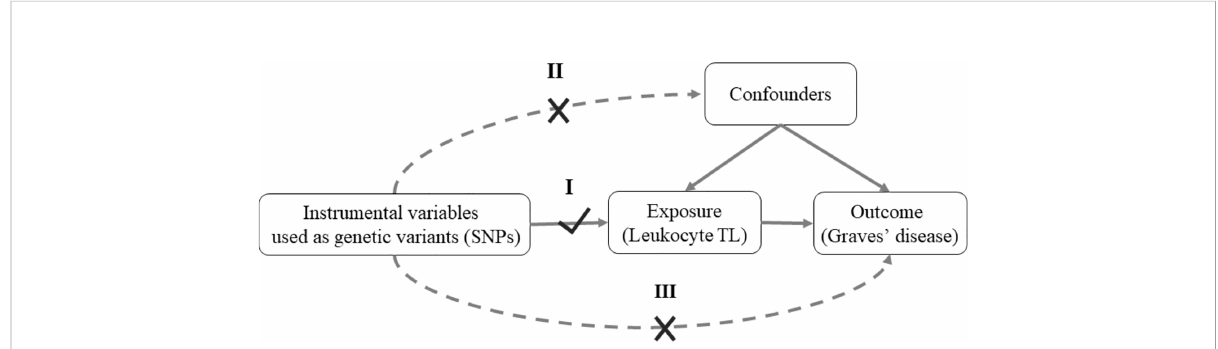
FIGURE 1 Mendelian randomization model of leukocyte TL and risk of Graves ’ disease. MR depends on three assumptions: I. Relevance: The genetic variants are associated with the exposure of interest (Leukocyte TL); II. Independence: The genetic variants are not associated with confounders; III. Exclusion restriction: The genetic variants affect outcome of interest (Graves ’ disease) except through their potential effects on the exposure (Leukocyte TL). Solid arrows represent causal effects; dashed arrows represent causal effects that are particularly violated by the IV assumptions. SNPs, single-nucleotide polymorphisms; TL, telomere